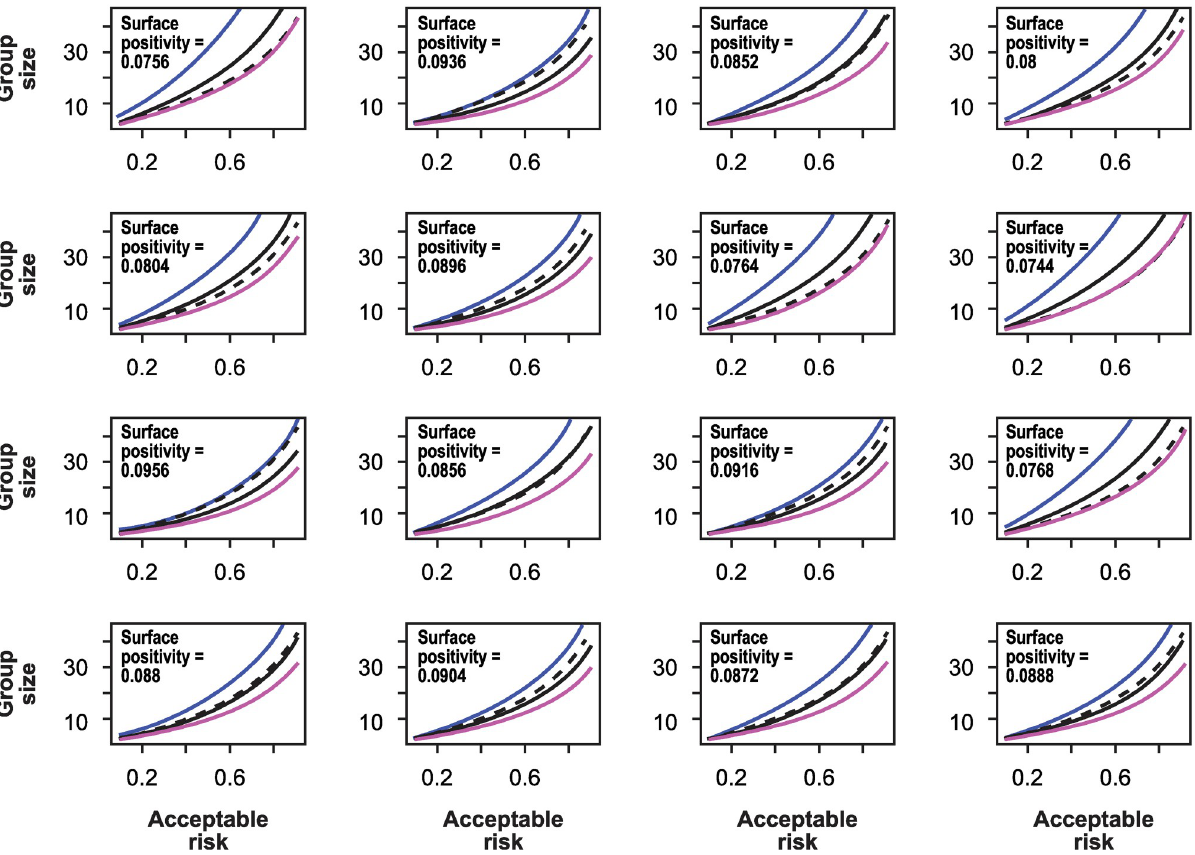
Fig 2. Sixteen realizations of the group size as a function of acceptable risk using the simulation methods described in [30]. In all panels, the number of tests is T = 2500, the true incidence rate is f = 0.05, and the probabilities of false negative and false positives tests are 0.25 and 0.05. The t dotted line shows the group size consistent with the level of acceptable risk when the incidence rate is f t , the solid black line is the group size using the estimate in Eq 1 determined using the positivity rate from the individual realization of the simulation, and the red and blue lines are the group sizes using the maximum and minimum estimates for incidence rate, f ¼ ^ f þ 0 : 5 � Range ð ^ f ) and f ¼ ^ f (cid:0) 0 : 5 � Range ð ^ f Þ , respectively. One key upper lower observation is that the group size determined if the incidence rate were known (dotted line) falls between those determined from the upper and lower limits of incidence rate determined by the test